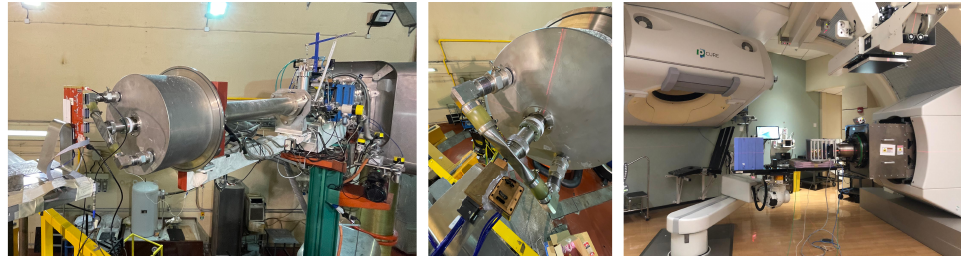
Figure 9. ENEA-FNG facility during MB irradiation ( left ) and ROU irradiation ( centre ). Northwest- ern Medicine Warrenville Proton Center ( right ).